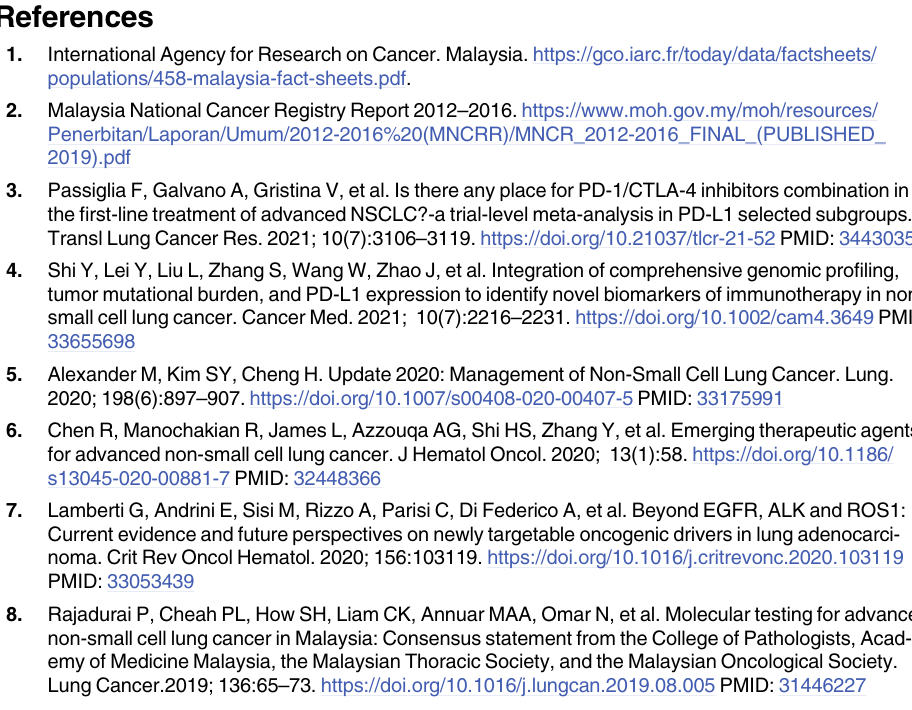
S1 Table. Summary of sequencing metrics of 4 independent runs by using Illumina MiSeq Reagent Kit v3 (600-cycle). S2 Table. Summary of the variants detected by custom 15-gene ctDNA panel. The analysis was performed by Archer Analysis software. S3 Table. List of regions covered in custom 15-gene ctDNA